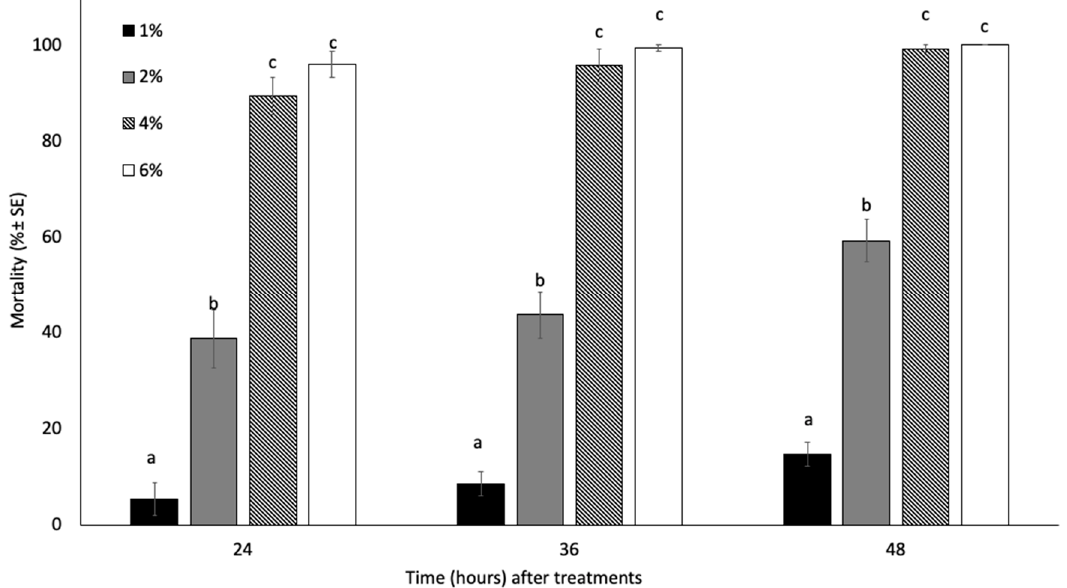
Figure 1. Mean percent mortality ± SE of A. gossypii adults exposed to different concentrations of Citrus sinensis EO nano-emulsion after 24, 36, and 48 h in laboratory trials. Different letters indicate statistical differences among the different treatments at the same exposure time (ANOVA, p < 0.05).